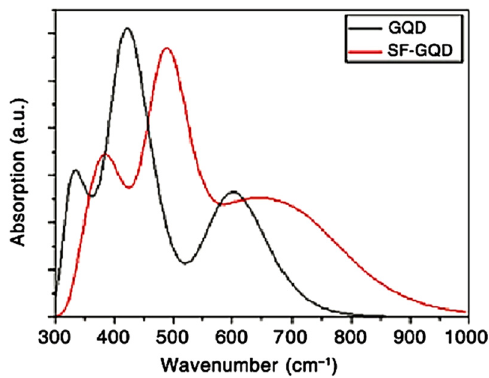
Figure 5: Comparison of the UV - Vis absorption spectra of GQDs and surface functionalized GQDs [ 86 ]